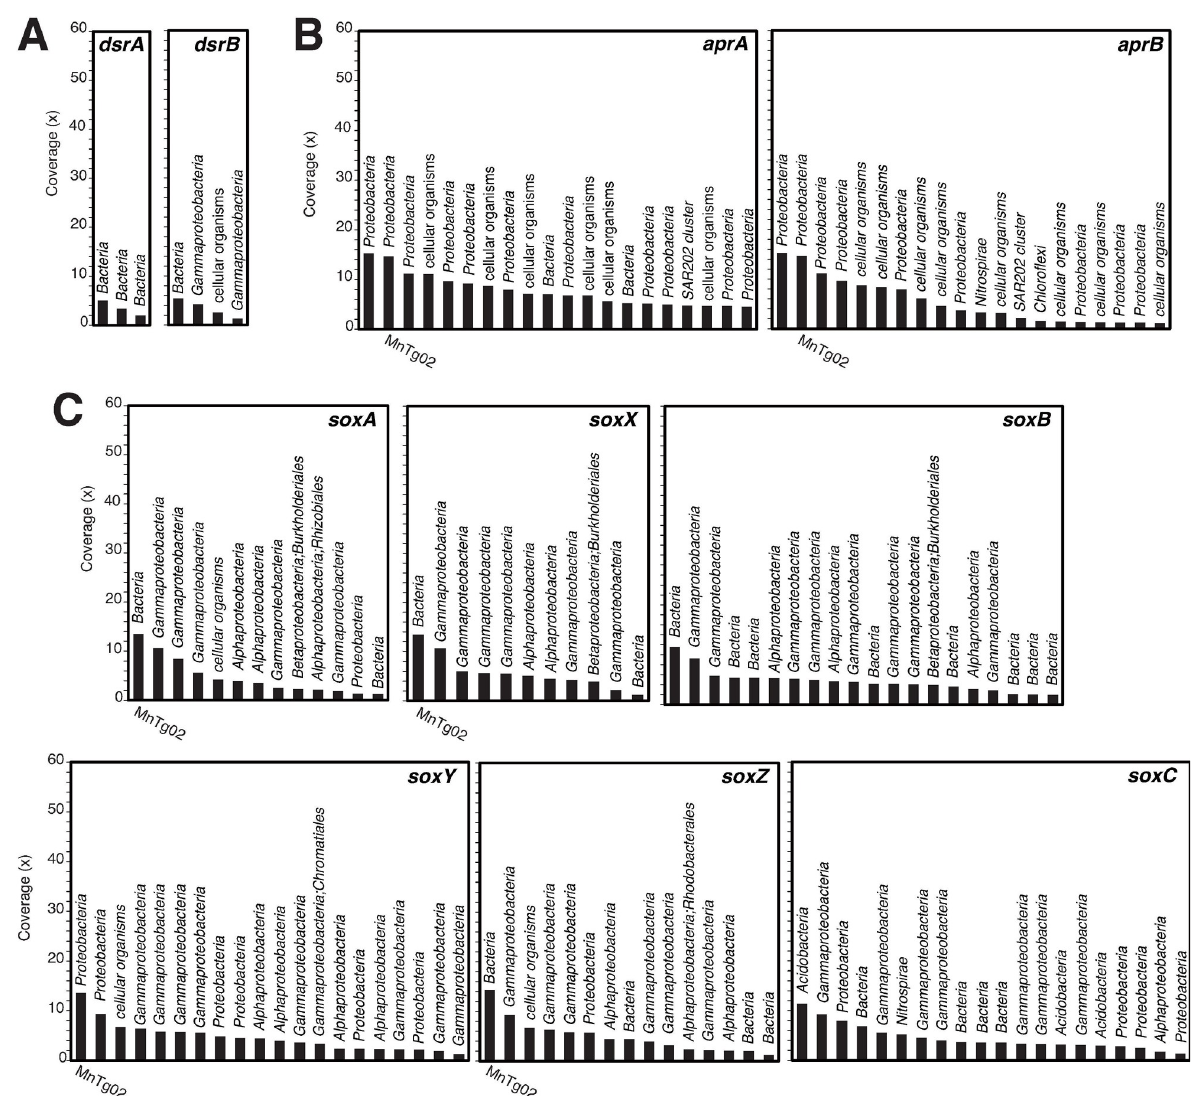
Fig 3. Read-coverage-based rank abundant plot of contigs containing CDSs potentially involved in sulfur oxidation. CDSs of (A) DsrAB, (B) AprAB, and (C) SoxABCXYZ. Taxonomic affiliations for the CDSs are indicated on the bars. The IDs of metagenome-assembled genomes (MAGs) are shown for the contigs containing CDSs identical to those of the